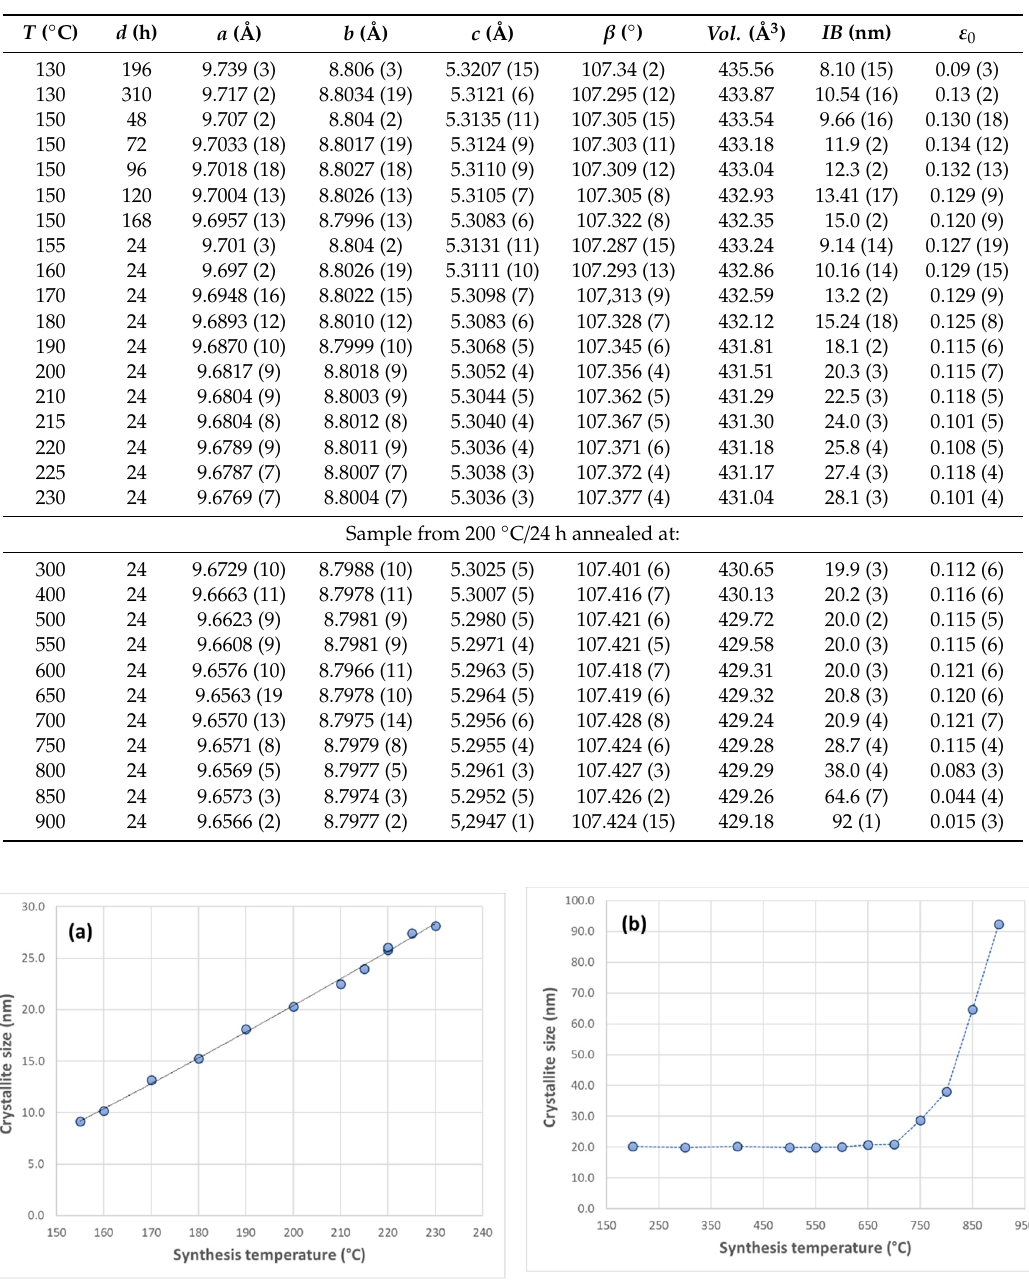
Table 1. Unit cell dimensions, crystallite size and microstrain as determined from Rietveld analysis of powder X-ray di ff raction data of aegirine NaFeSi 2 O 6 , synthesized at di ff erent temperatures T and holding times d , and for sample material of the 200 ◦ C / 24 h experiment, sintered at di ff erent temperatures for 24 h each. IB is the crystallite size, obtained from the integral breath of the peaks.